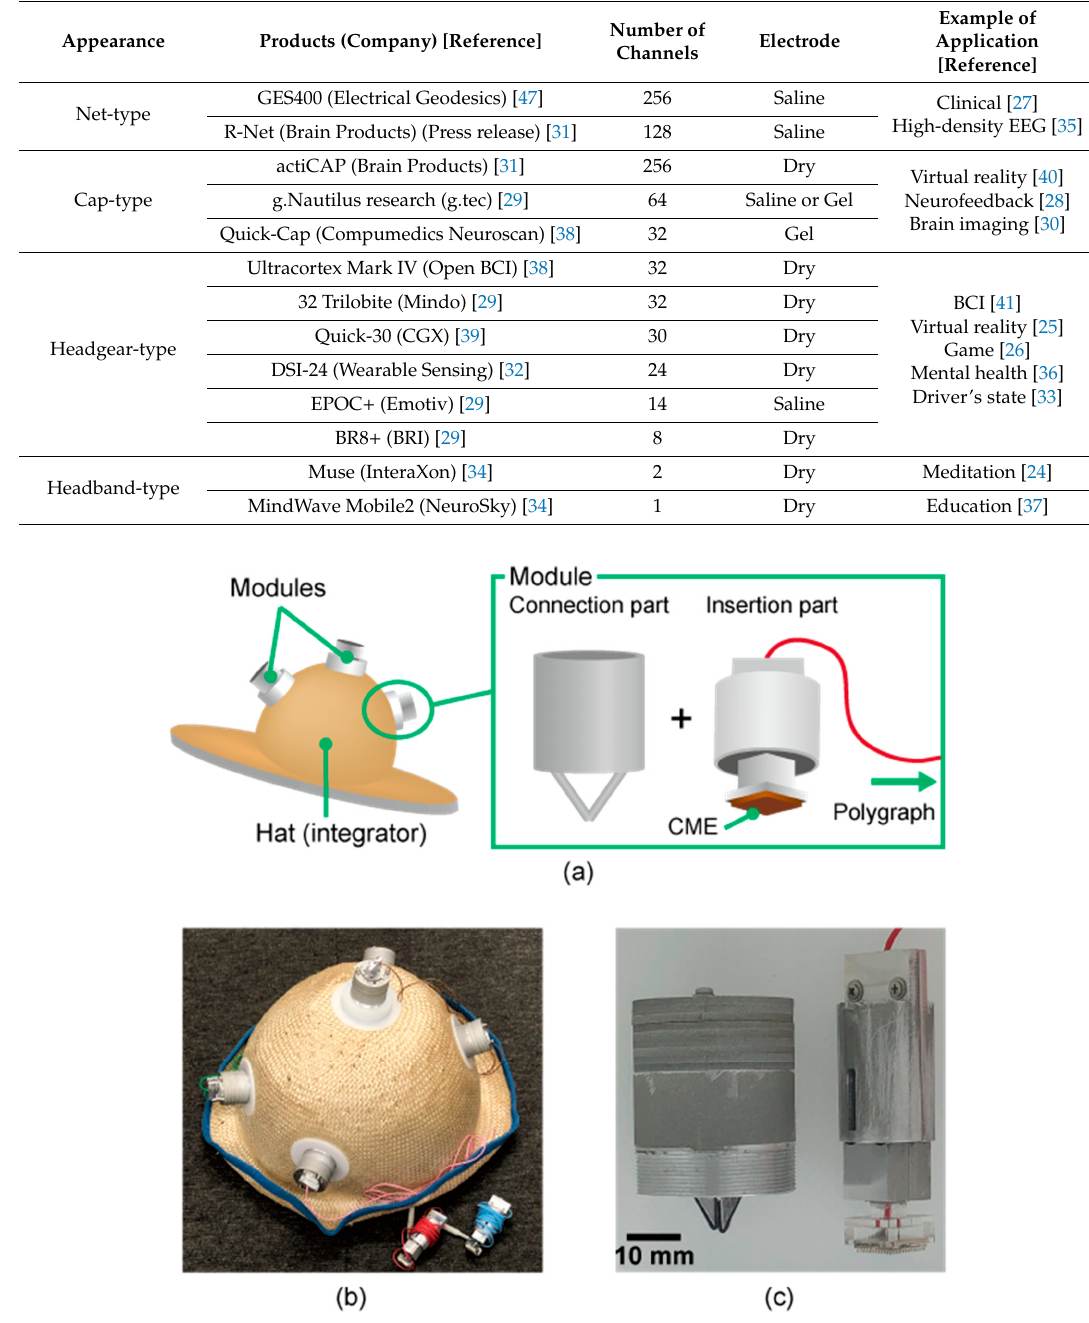
Figure 2. ( a ) Overview of the EEG-Hat. The EEG-Hat consists of independent modules and a woven hat that integrates the modules. Each module consists of a connection part and an insertion part. ( b ) The overall appearance of the EEG-Hat. Five modules are connected to the hat with white attachment parts. ( c ) Fabricated module. The connection part has a screw on the bottom to connect it to the attachment part. The CMEs are mounted in the insertion part.